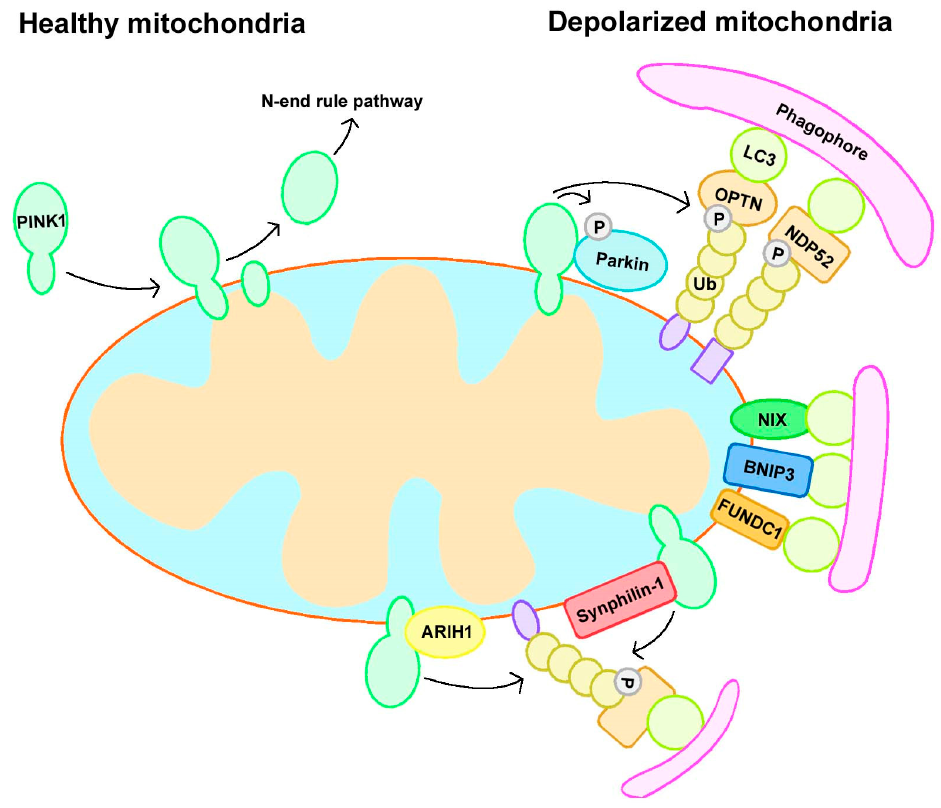
Figure 1. Mitophagy pathways. Mitophagy can be divided into Parkin-dependent or independent pathways. Under normal conditions, PINK1 localizes to mitochondria and is translocated to the mitochondrial inner membrane (MIM), where it is cleaved and subsequently degraded by an N-end rule pathway. However, when mitochondria become depolarized, PINK1 accumulates at the outer mitochondrial membrane (OMM) and recruits Parkin. Activated Parkin leads to the ubiquitination of substrates and the recruitment of autophagy receptors to initiate mitophagy. In addition, Parkin-independent mitophagy includes receptor-mediated and ubiquitin ligase-mediated mitophagy. BNIP3, BCL2 / adenovirus E1B 19 kDa interacting protein 3; FUNDC1, FUN14 domain-containing protein 1; NDP52, nuclear dot protein 52 kDa; NIX, BCL2 / adenovirus E1B 19 kDa interacting protein 3 like; OPTN, optineurin; Ub, ubiquitin.